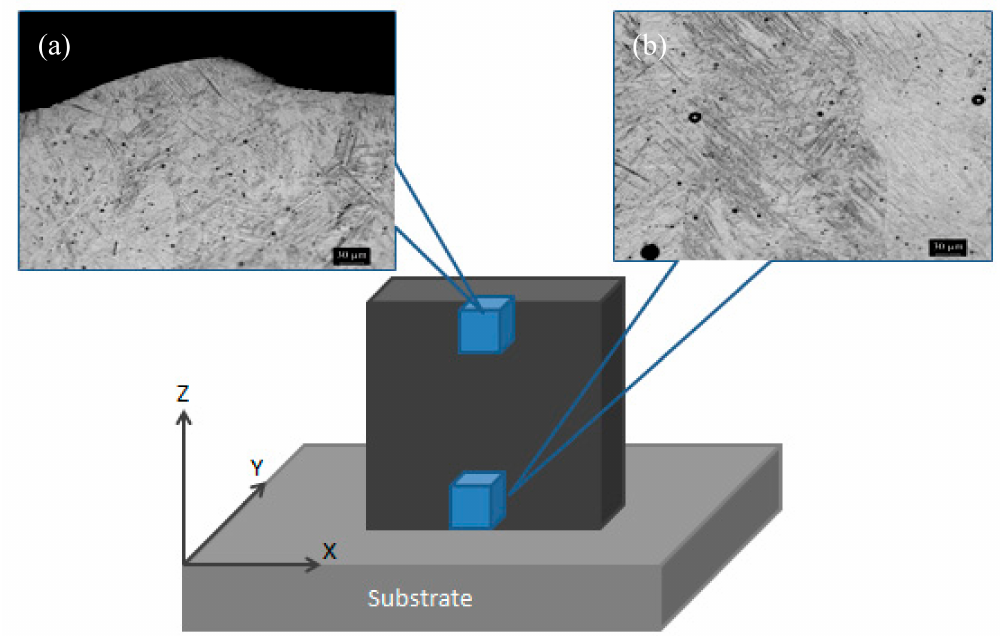
Figure 10. Microstructure of a direct laser-deposited Ti-6Al-4V part in Y–Z plane at ( a ) the top region and ( b ) the bottom